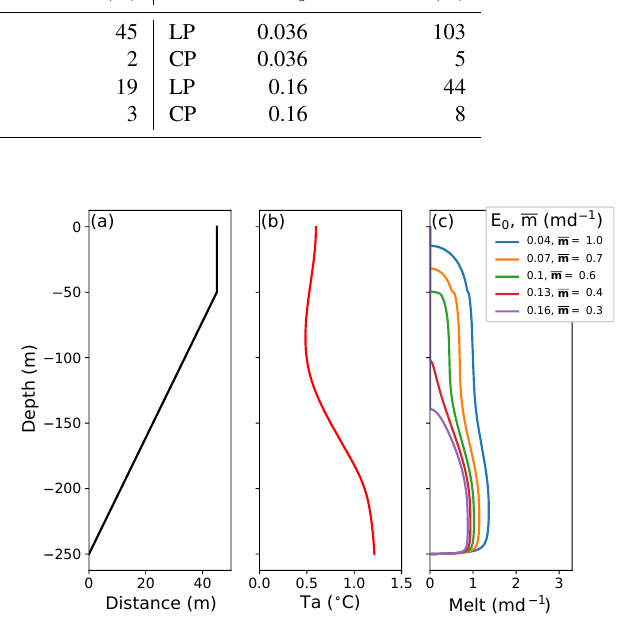
Figure 13. Kangerlussuup Sermia average undercut profile at the terminus (a) with the assumed temperature profile (b) give dif- ferent melt rate profiles (c) simulated for different E 0 and same Q sg = 208m 3 s − 1 . All average melt rates are below the determined 2mday − 1 by Fried et al.